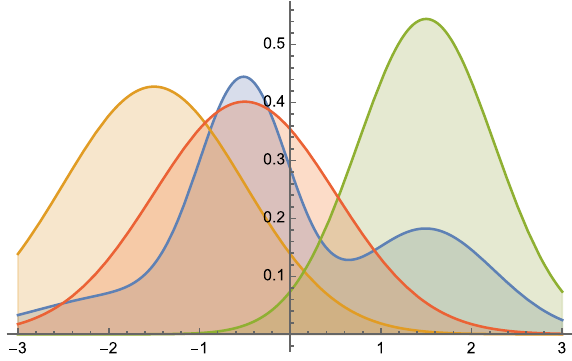
Fig. 11 Example 4: f ( x )/µ (in blue) superimposed with the three pdfs used for MIS integration